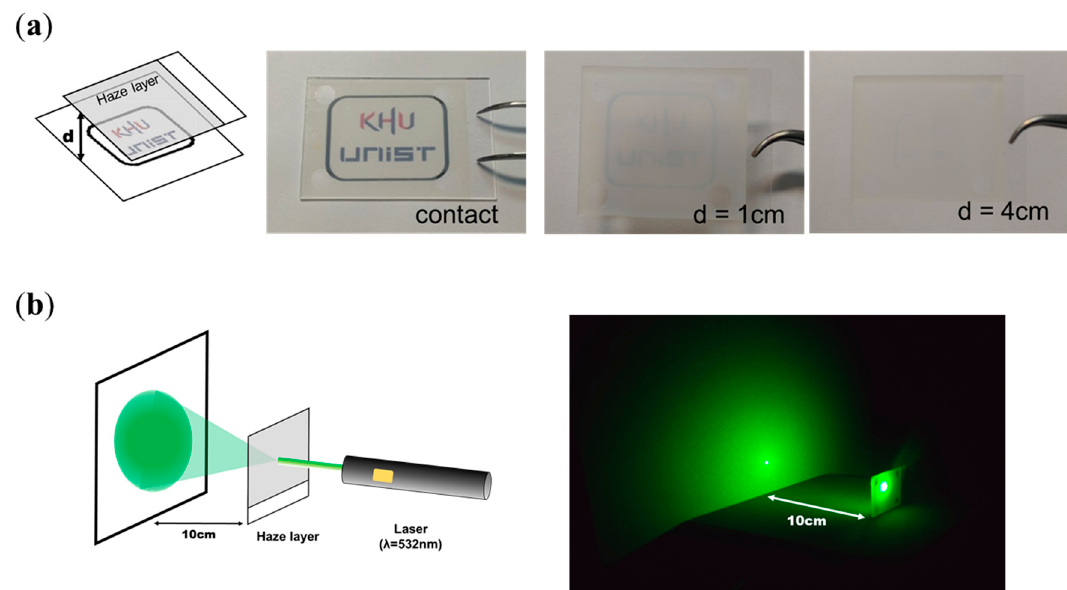
Figure 2. ( a ) Photographs of the MSLC film placed between the printed logo and the camera. The MSLC film is spaced apart from the logo by varying distances (d = 0, 1, and 4 cm). ( b ) Image of a green laser ( λ = 532 nm) beam irradiated onto the screen after passing through the MSLC film.